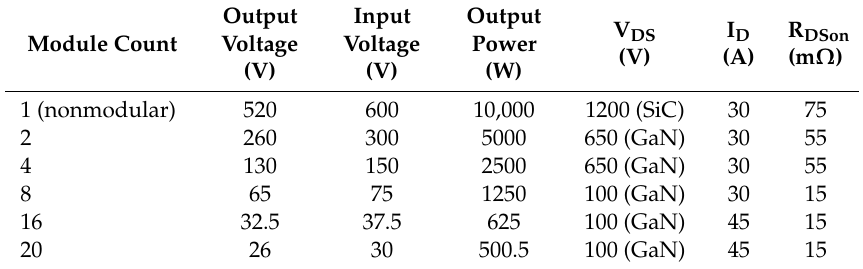
Table 2. Table of input / output variations for various bi-BB concepts dependent on Nr. of